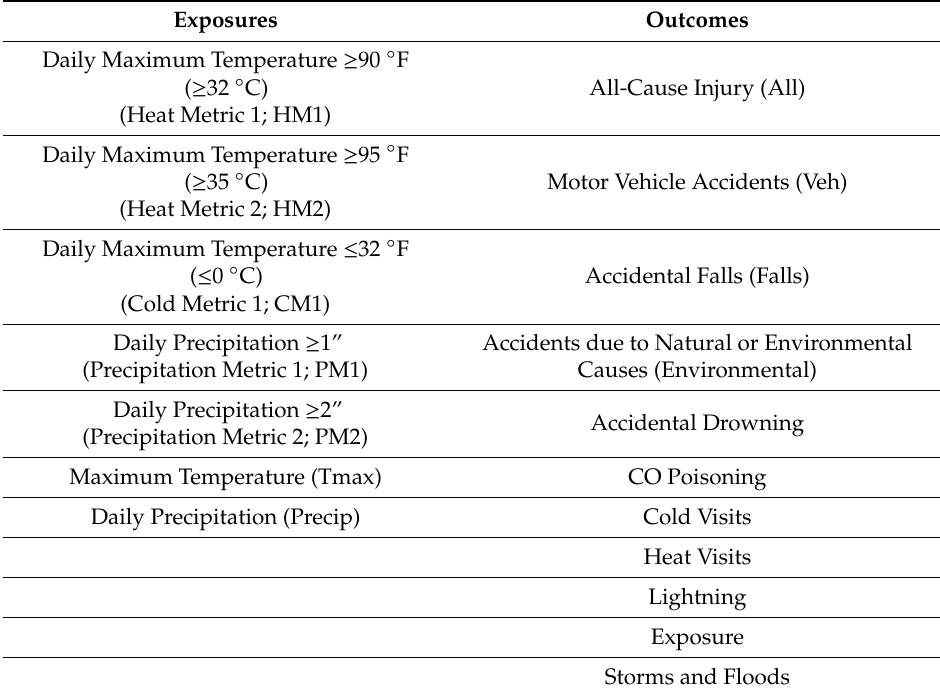
Table 3. Exposure variables and outcome variables used in this